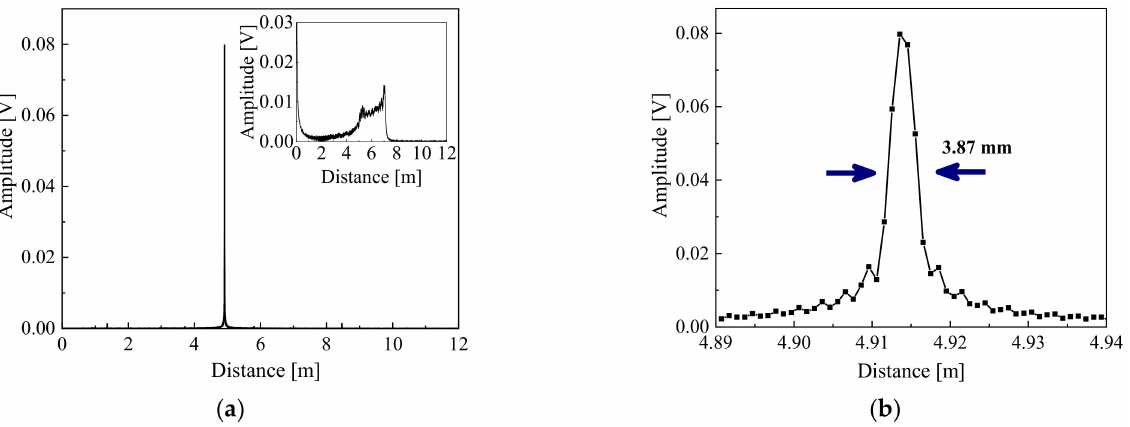
Figure 8. ( a ) Entire distance spectrum of the measurement interference signal. Inset: distance spectrum without frequency-resampling and filter processing. ( b ) Zoomed-in view of ( a ) around 4.9 m, showing a full width at half maximum of 3.87